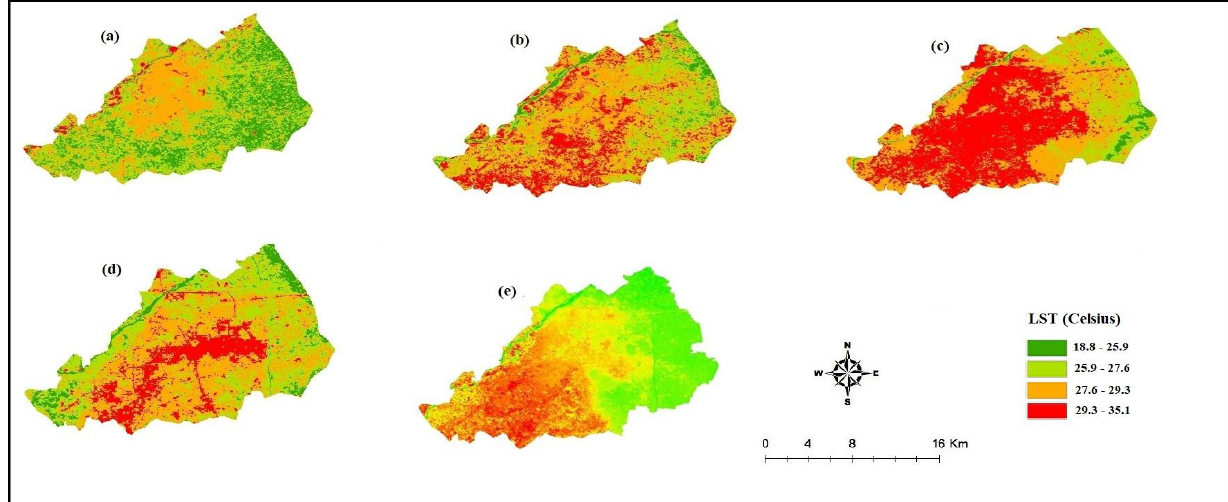
Figure 6. Spatio-temporal Analysis of Land Surface Temperature